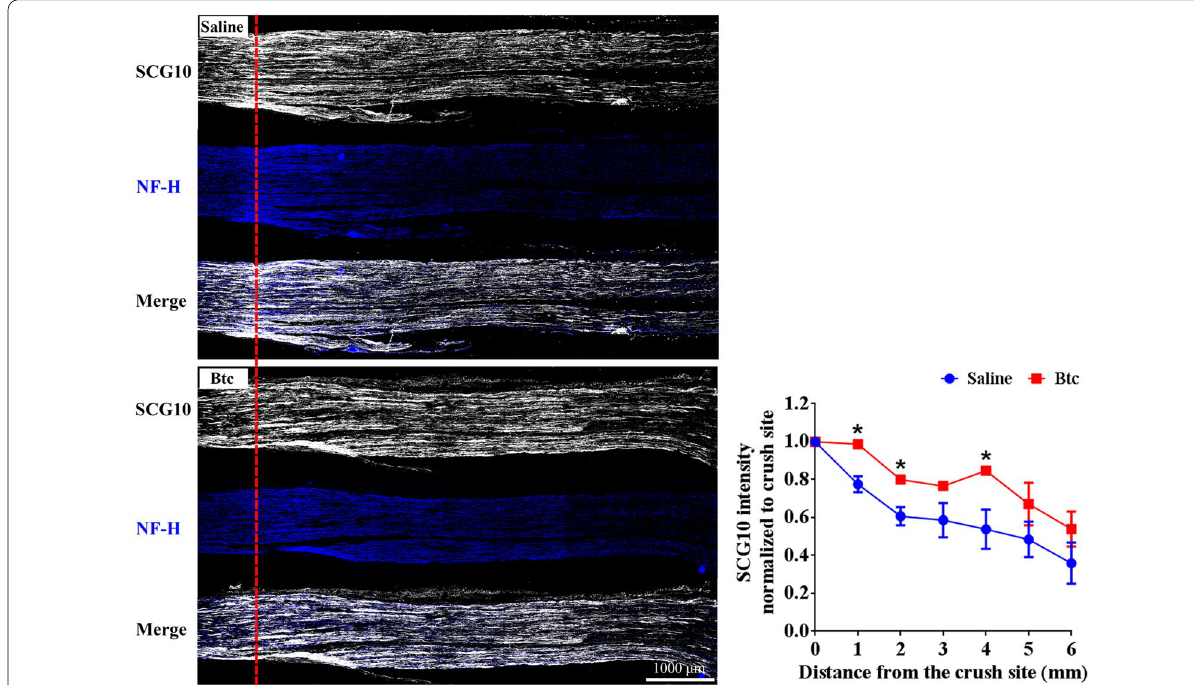
Fig. 5 The in vivo effect of Btc recombinant protein after rat sciatic nerve crush. Representative immunofluorescence images of rat sciatic nerve segments treated with saline control or Btc recombinant protein at 4 days after nerve crush. Averaged intensity of SCG10 at 1, 2, 3, 4, 5, and 6 mm from the crush site were normalized to its intensity at the crush site. Scale bar indicated 1000 µm. Axon length was summarized from three experiments. Statistical evaluation was performed using multiple t-test. *p-value < 0.05 versus saline